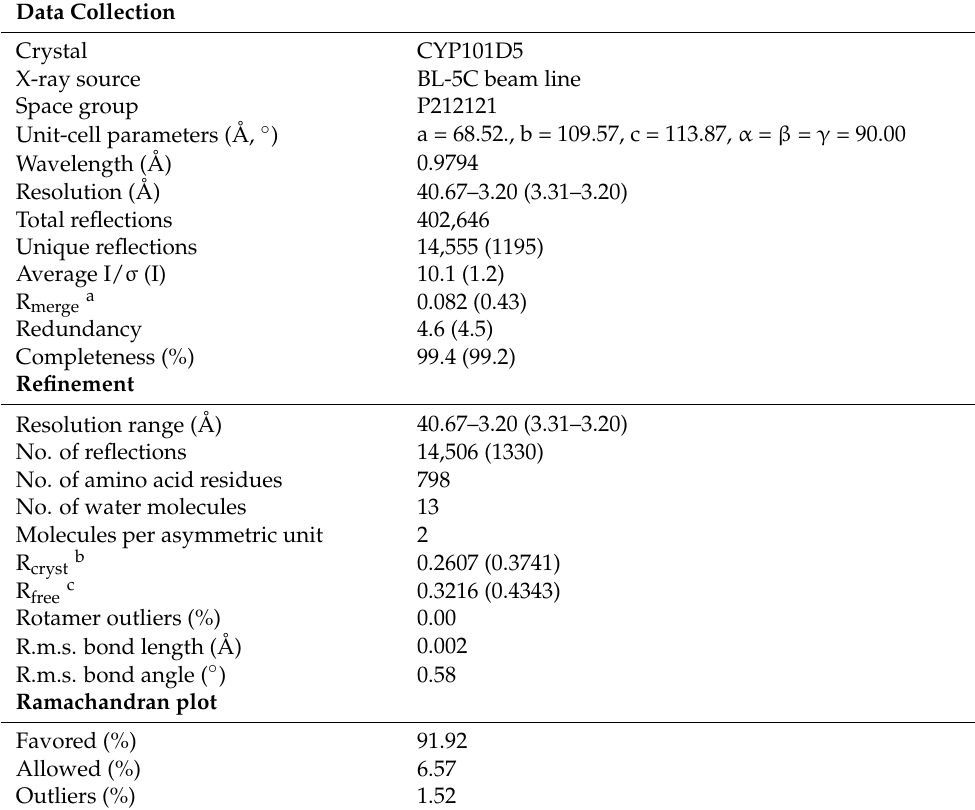
Table 2. X-ray diffraction data collection and refinement